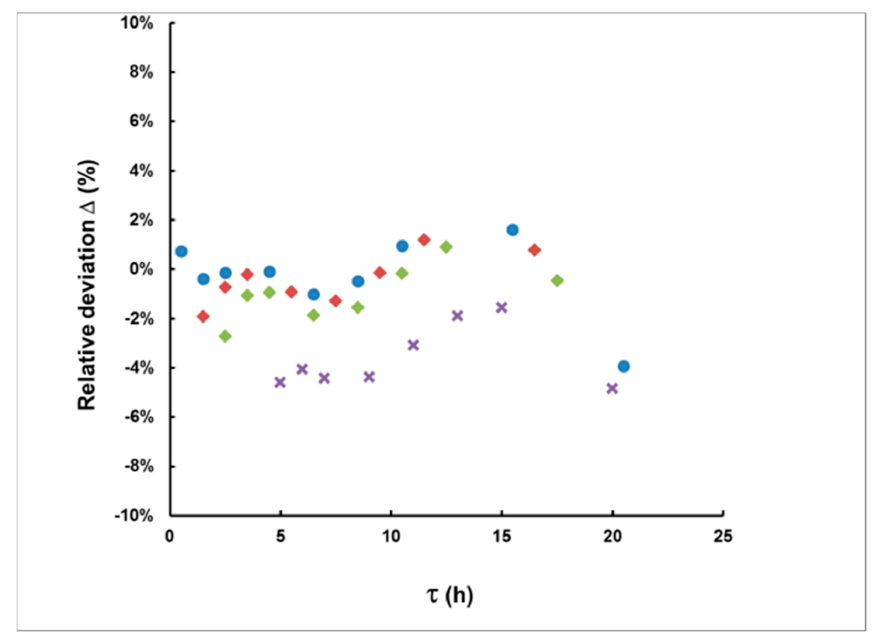
Figure 8. The relative deviation in I A ( ∆ = ( I A (calculated) − I A (true))/ I A (true)) for delays of up to 20 h. The duration of the simulated rectangular plumes is 1 h ( • ), 3 h ( (cid:7) ), 5 h ( (cid:7) ) and 10 h ( ×